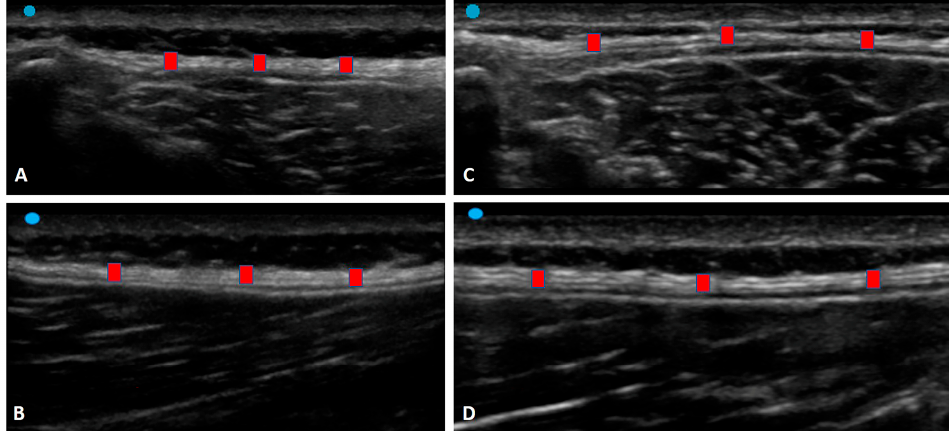
Figure 4. Ultrasound images of the TLF thickness: ( A ) Group 1: transverse axis; ( B ) Group 1: longitudinal axis; ( C ) Group 2: transverse axis; ( D ) Group 2: longitudinal axis. Red square: TLF.